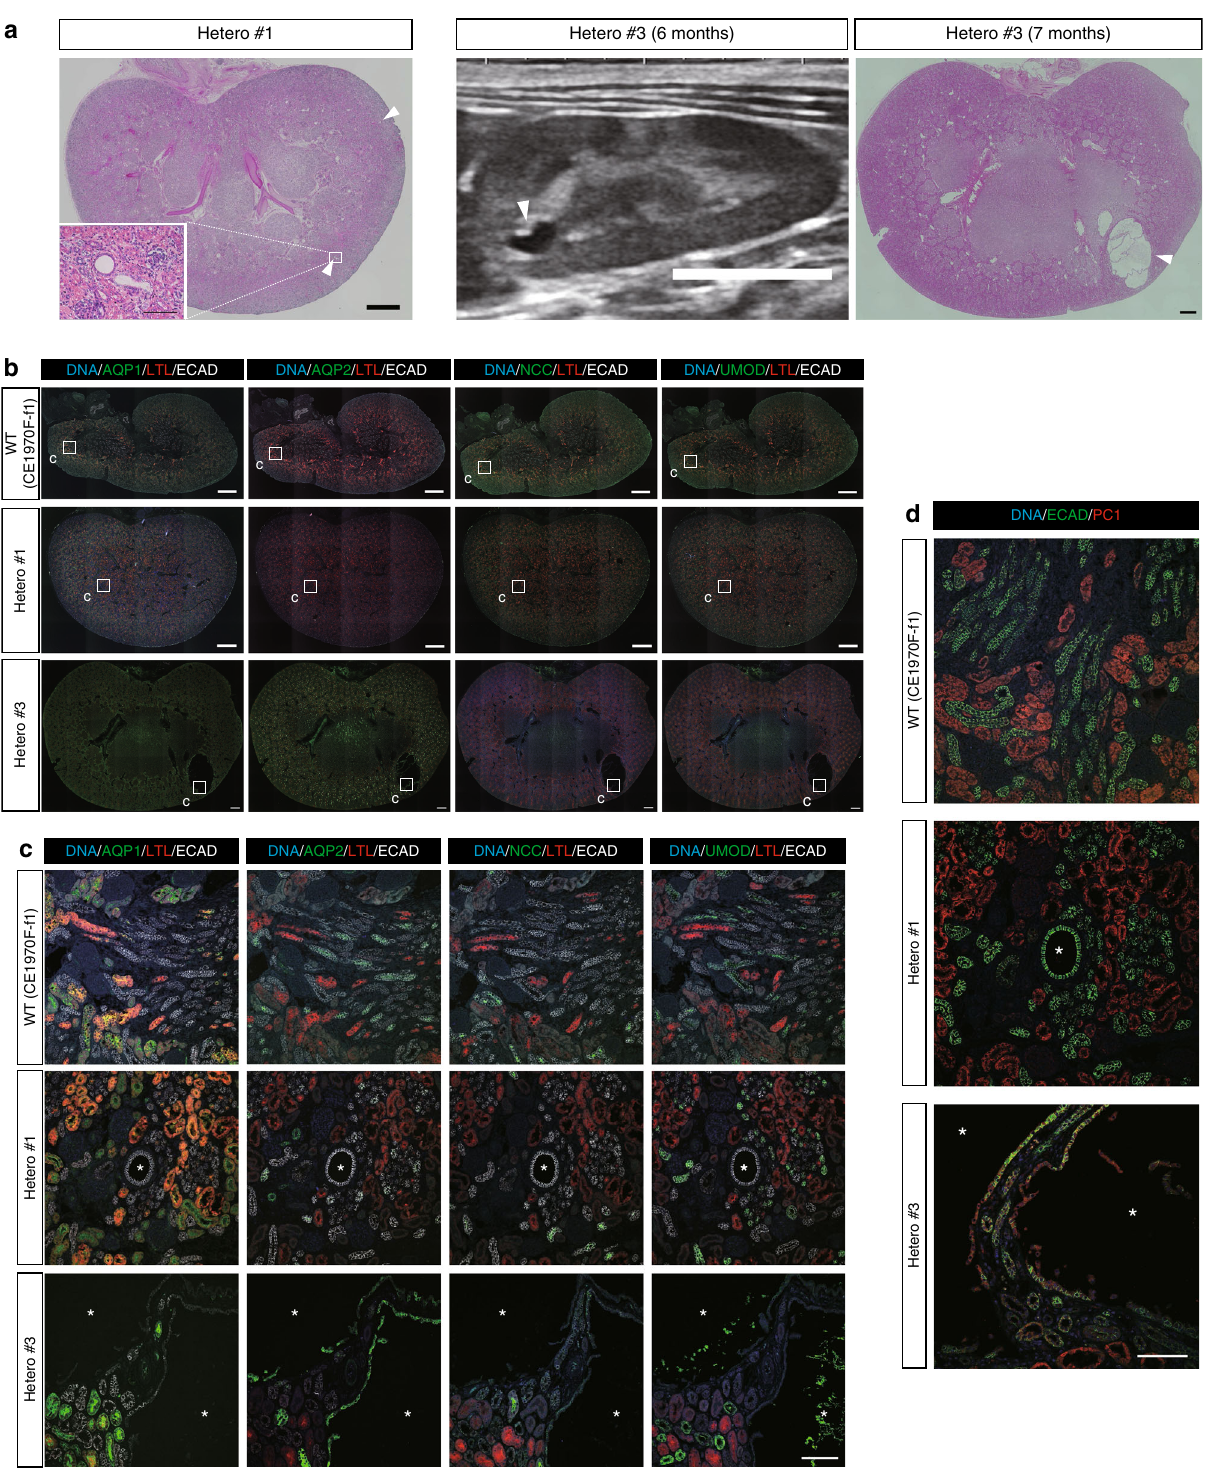
Fig. 6 Heterozygotes exhibit distal-tubules-derived small cysts. a Low-power, H&E-stained images and ultrasonography image of heterozygous kidneys. Scale bars in large H&E-stained images, 1 mm. Scale bar in the small box, 100 µ m. Scale bar in the ultrasonography image, 10 mm. b Expressions of nephron segment markers in heterozygous kidneys. Small boxes indicate the regions shown at high magni fi cation in c . Scale bar, 1 mm. c Representative ECAD- positive and AQP1-, AQP2-, NCC-, and UMOD-negative cysts and AQP2-positive cysts in heterozygous kidneys. Asterisks indicate cysts. Scale bar, 100 µ m. d Expressions of ECAD and PC1 in heterozygous kidneys. One representative PC1-negative cyst in Hetero #1 and two PC1-positive cysts in Hetero #3 are shown. Asterisks indicate cysts. Scale bar, 100 µ